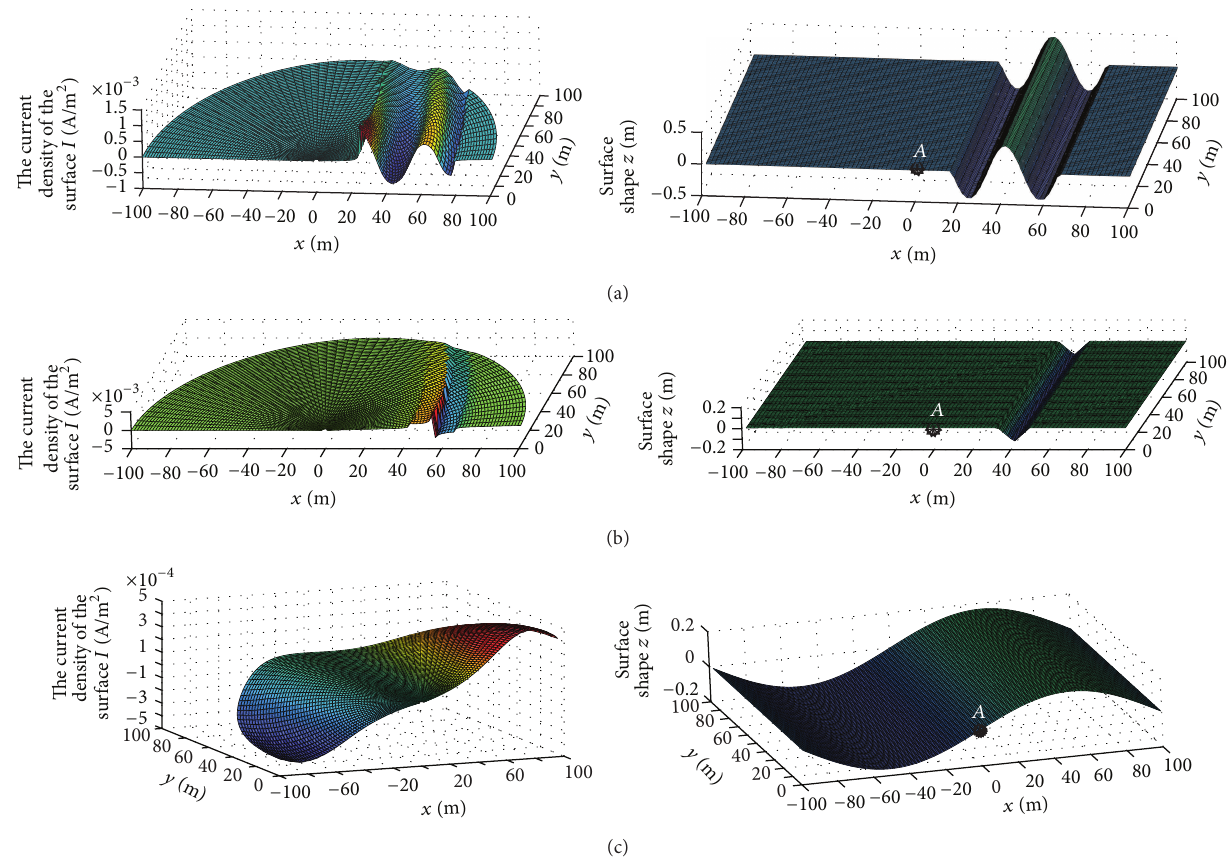
Figure 2: Effect of ground surface relief, current densities of secondary sources for different shapes of surface